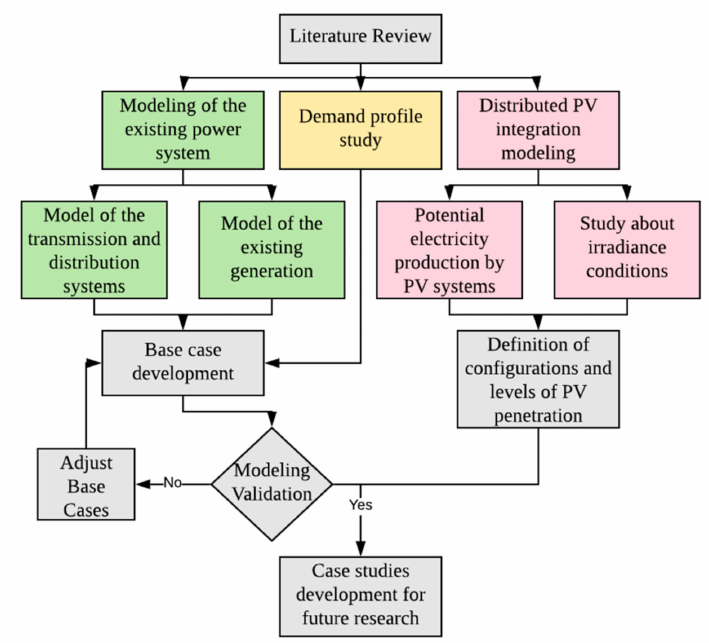
Figure 2. Steps for modeling and evaluation of isolated electric power systems with potential electricity production from PV-based